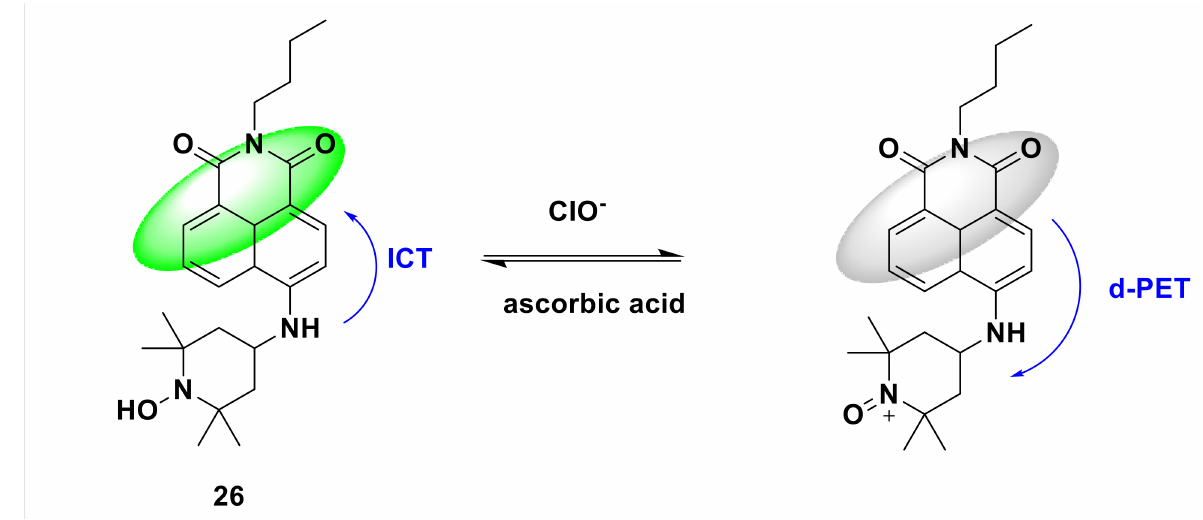
Figure 26. The reaction of probe 26 and ClO − .